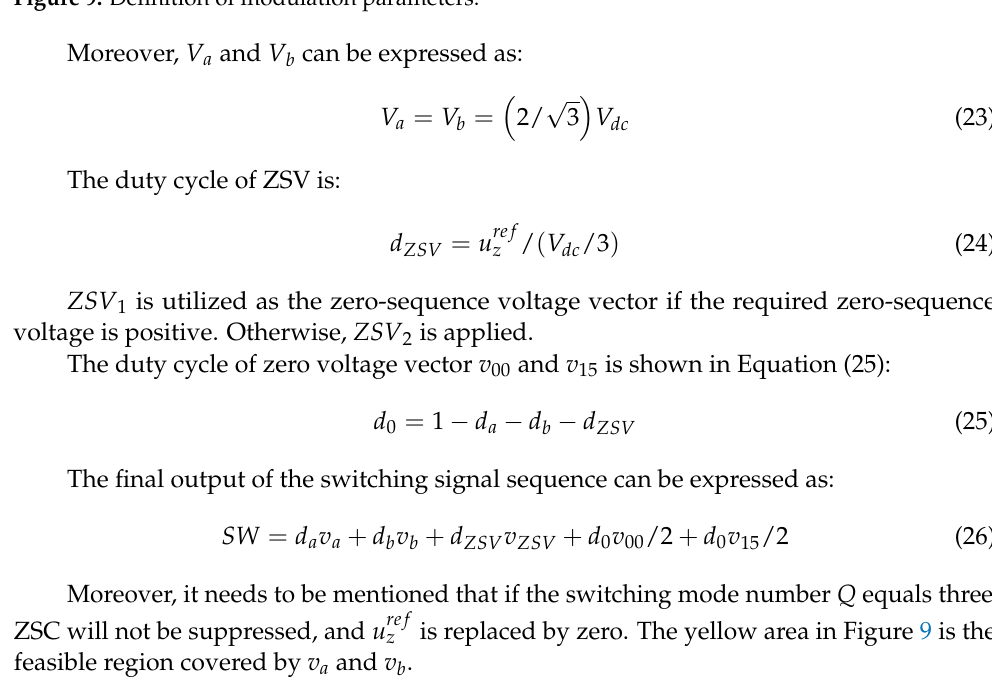
Figure 9. De fi nition of modulation parameters. Figure 9. Definition of modulation